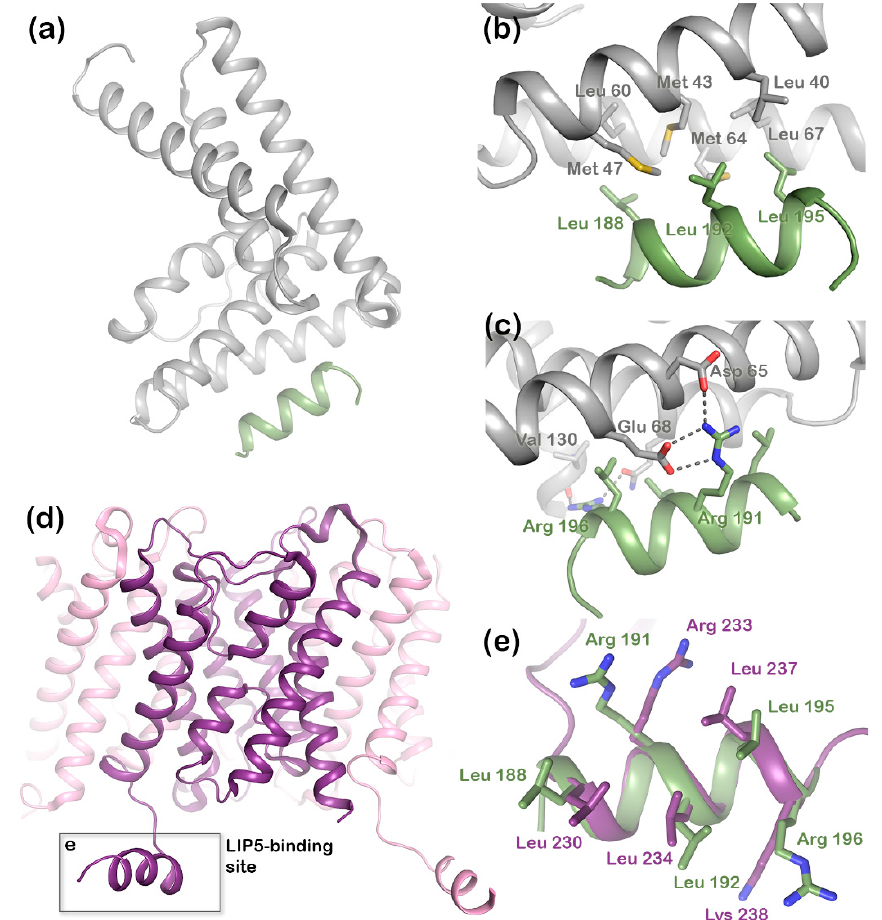
Figure 2. Structures of human lysosomal trafficking regulator-interacting protein 5 (LIP5) and aquaporin 2 (AQP2). ( a ) Crystal structure of the N-terminal domain of human LIP5 (grey, PDB code 4TXQ) in complex with a peptide from the ESCRT-III component, CHMP1B (green). Zoomed-in view of the LIP5-CHMP1B complex interface showing ( b ) hydrophobic and ( c ) hydrophilic interactions. ( d ) Crystal structure of human AQP2 tetramer (PDB code 4NEF) showing the classic AQP monomer fold (dark purple) with six transmembrane helices. The C-terminus extends into the cytoplasm and forms a short helix that is conserved in mammalian AQPs. ( e ) Overlay of the MIT-interacting motifs present in AQP2 C-terminal helix (purple) and the LIP5-binding segment of CHMP1B (green). In addition to interacting with ESCRT-III and Vps4, LIP5 has also been shown to directly bind the membrane protein cargo. This includes AQP2, which has been shown to co-localize with LIP5 in MVB inner vesicles and for which the interaction with LIP5 facilitates its lysosomal degradation [12].